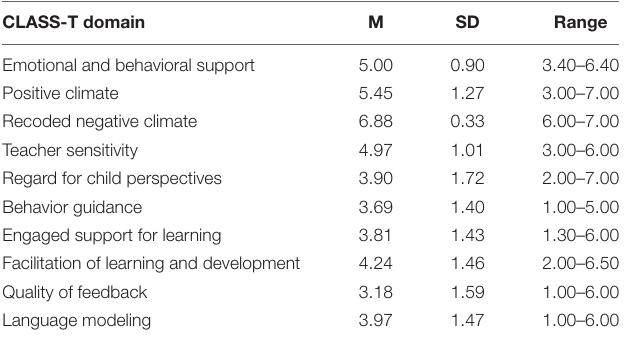
TABLE 2 | Descriptive statistics for overall classroom quality (CLASS-T).